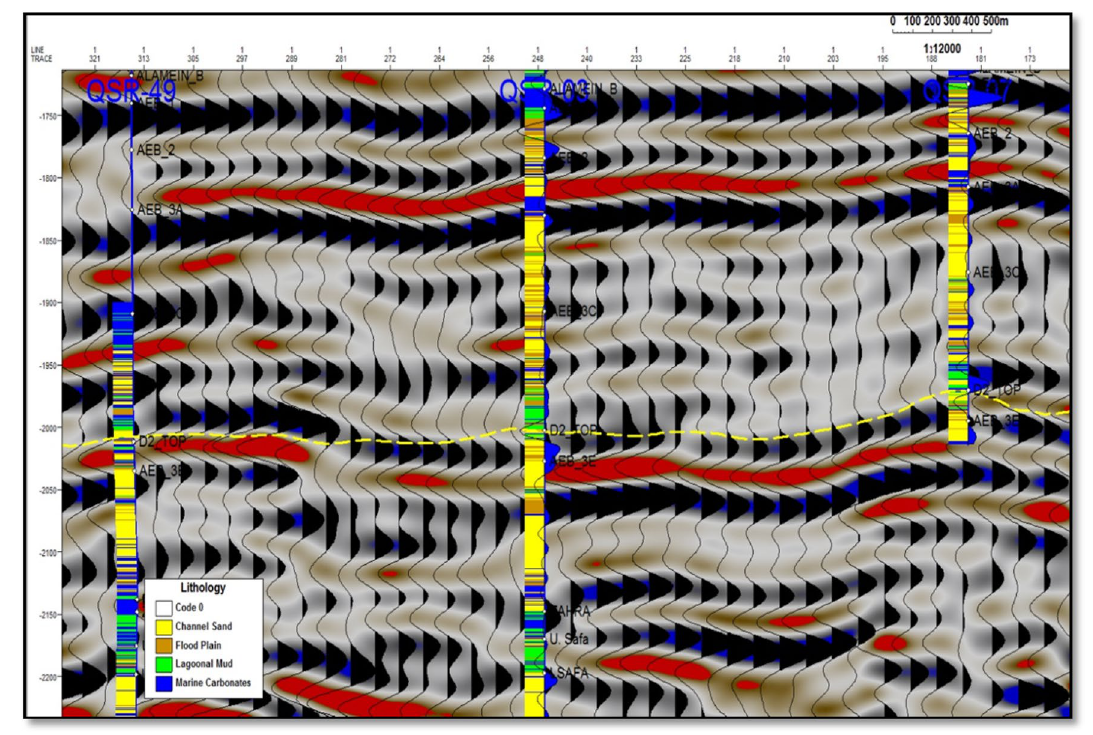
Fig. 15 NW–SE seismic section along wells Qasr-49–03–07. Lithology and synthetic positive amplitude (blue) are displayed in each well. Amplitude wiggles are displayed (black wiggles are positive amplitudes). Top D2 sand unit in dashed yellow